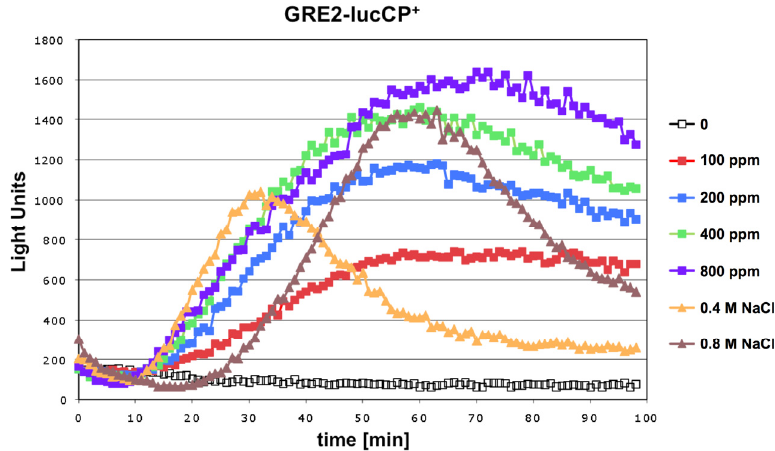
values from three independent biological samples. SD < 15%.